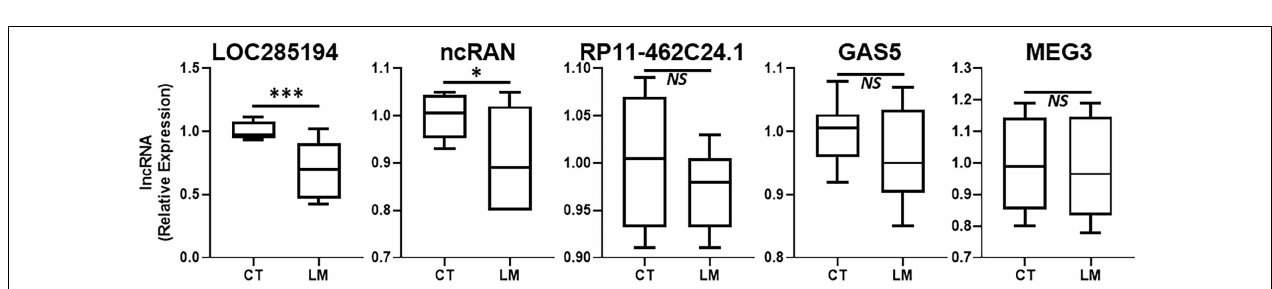
FIGURE 1 | Upregulated lncRNAs in colorectal cancer liver metastases. Expression levels of several lncRNAs were tested in liver metastases of primary colorectal cancers (LM), by qRT-PCR, and compared to their expression levels in adjacent non-cancer liver tissues (CT: control). N = 8 * p < 0.05, ** p < 0.01, *** p < 0.001, and NS , Non-significant.